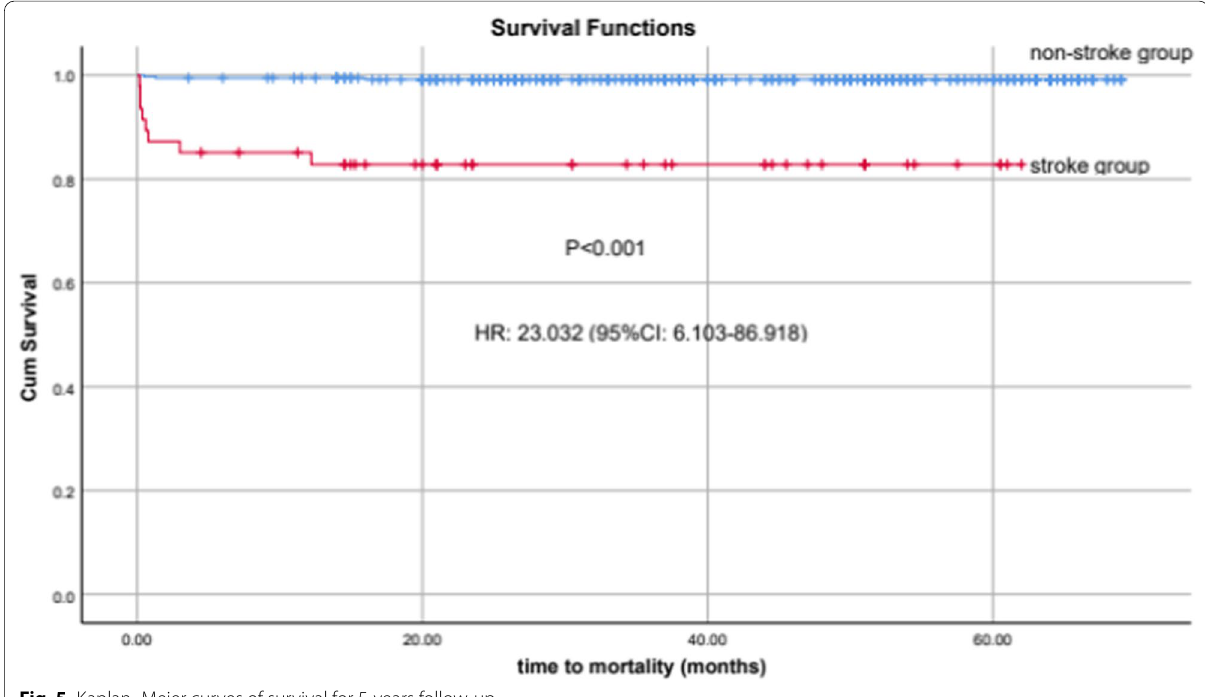
Fig. 5 Kaplan–Meier curves of survival for 5‑years follow‑up